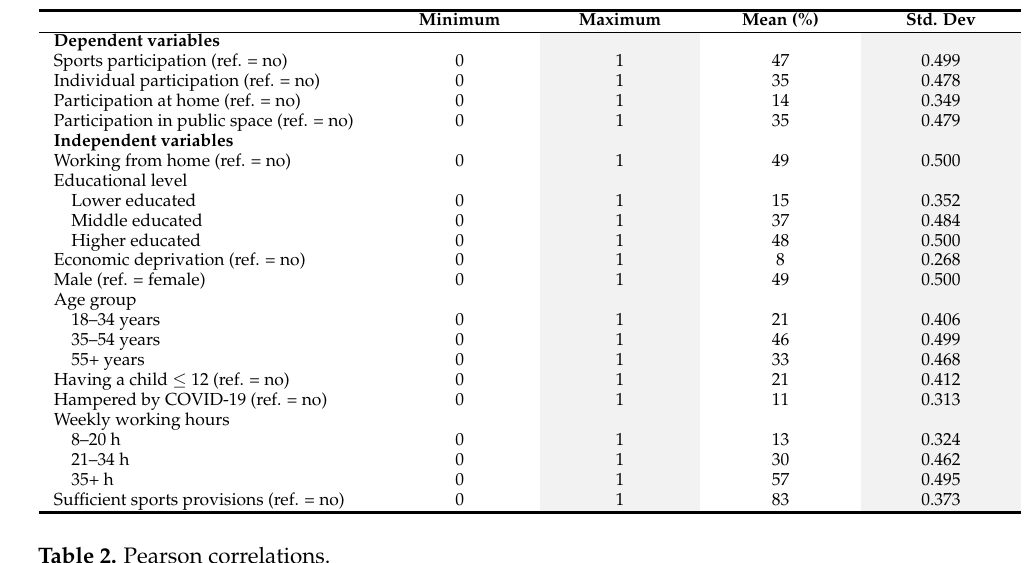
Table 1. Descriptives, N = 1506.